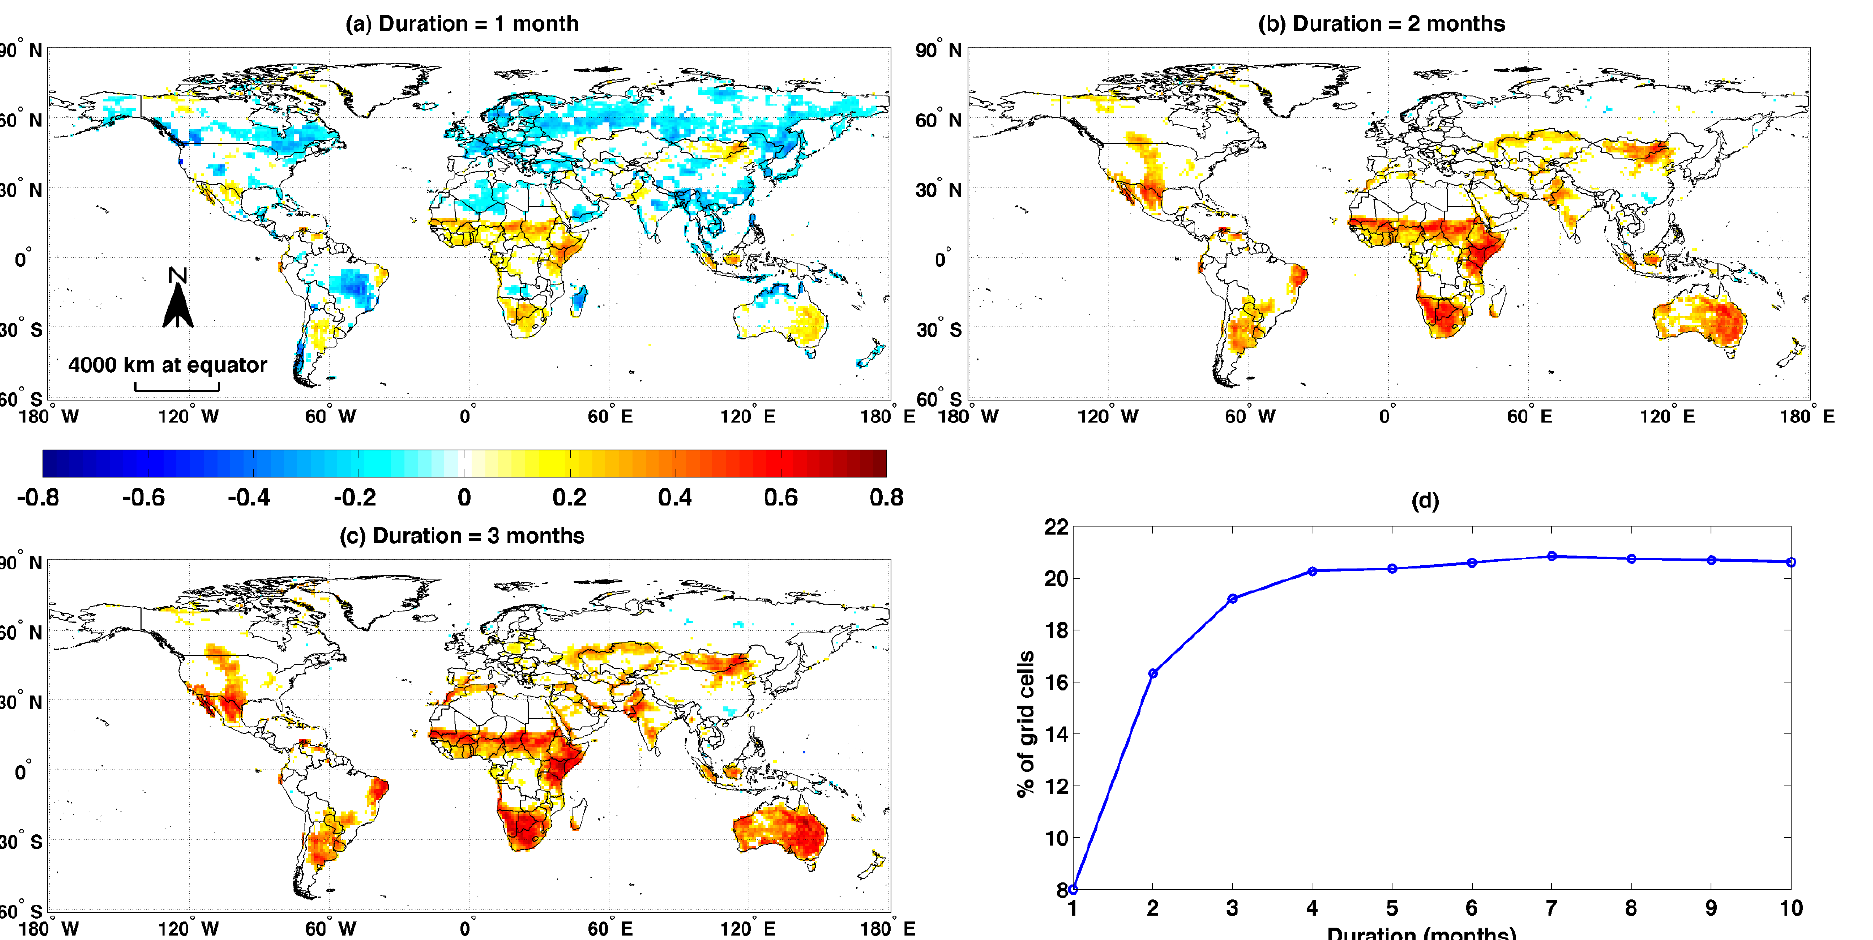
Figure 2. Global maps of correlation coefficients ( p * < 0.05) between all monthly GIMMS NDVI and cumulative Global Precipitation Climatology Project (GPCP) precipitation anomalies for durations varying from 1 to 3 months for 1982–2010 (( a – c) , N = 348 − duration + 1), and percentage of land grid cells that have significant ( p * < 0.05) positive correlation coefficients as a function of duration ( d ). Note that 1-month duration is equivalent to 0-month lead. All the correlation coefficients have been corrected for temporal autocorrelation (Spatial resolution: